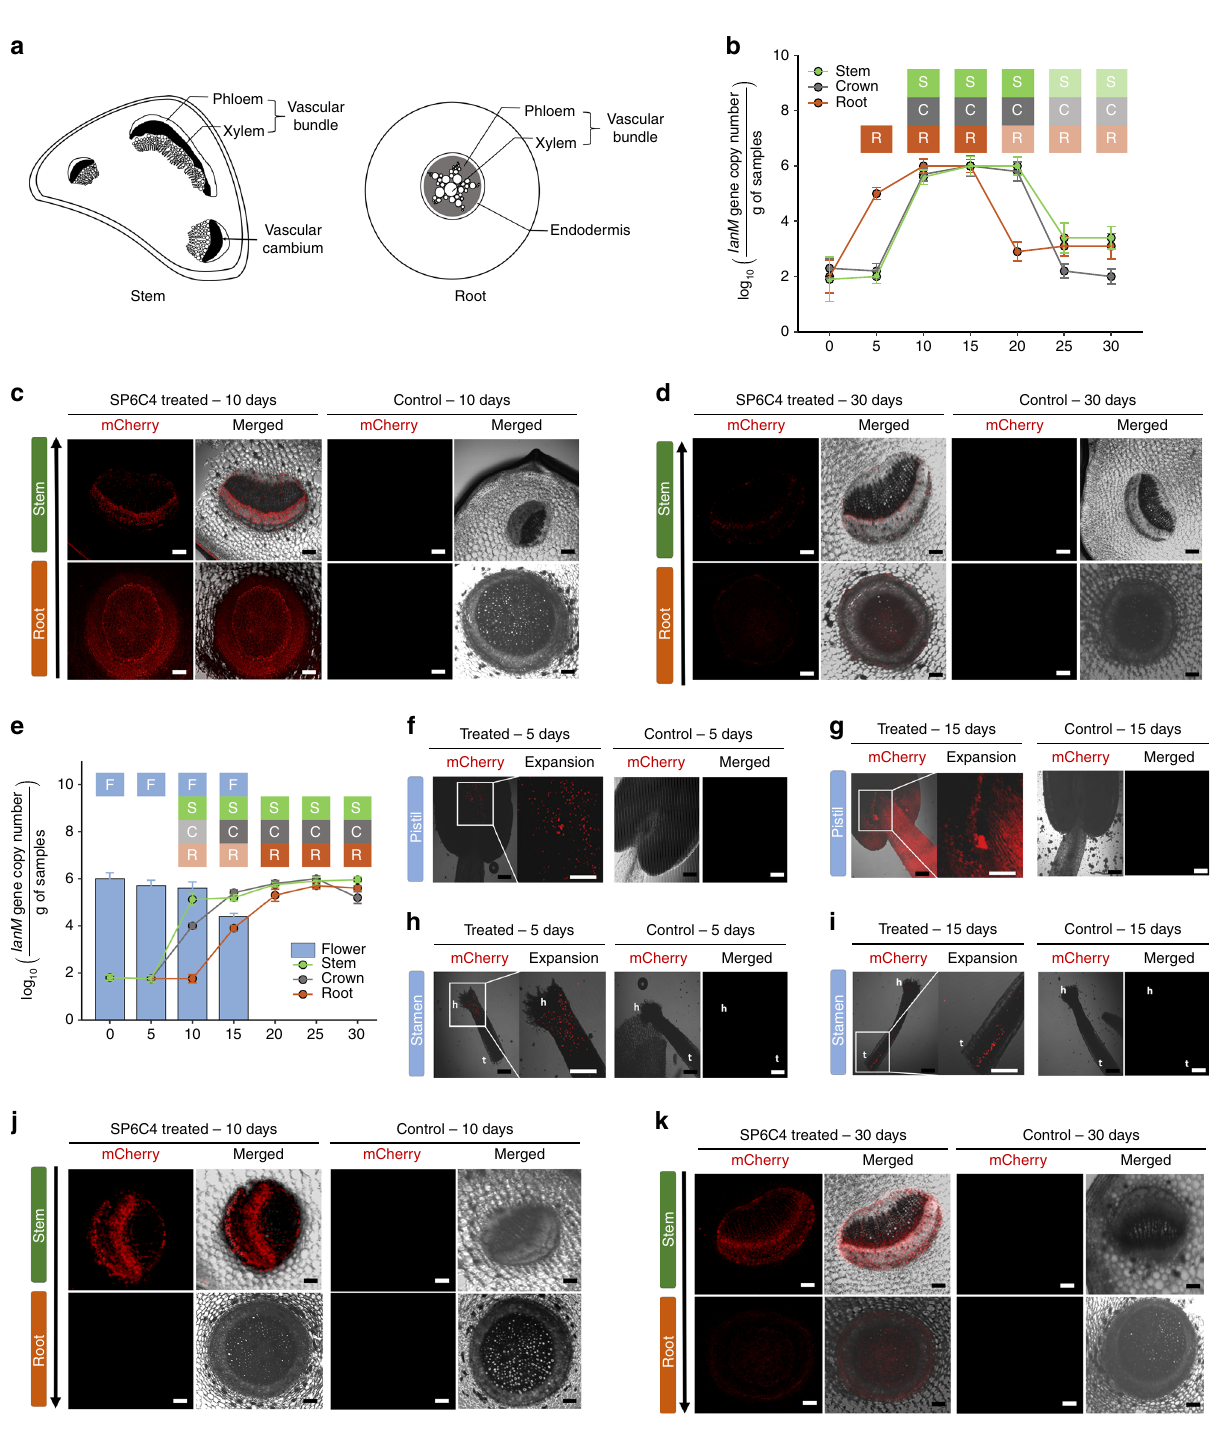
Fig. 4 Translocation of the S. globisporus SP6C4 from below- to above-ground and vice versa. a Illustration of the cross section of a strawberry stem and root. b S. globisporus SP6C4 was introduced onto the root surface in a suspension with 0.1% methyl cellulose. S. globisporus SP6C4 was detected with a lanM -speci fi c primer using qPCR SYBR Green ® TOYOBO master mix. Bars represent ± SE ( n = 3, 3 independent experiments). c Confocal microscopy of plant samples sectioned at 10 days. d 30 days after inoculation. Fluorescence of strain SP6C4-mCherry (530 – 560 nm detection channels) showing translocation from the rhizosphere to above-ground tissue. e Strain SP6C4 introduced on the fl ower and detected by lanM -speci fi c qPCR. Movement of the strain from above- to below-ground plant parts. Bars represent ± SE ( fl ower: n = 5, 3 independent experiments; root and stem: n = 3, 3 independent experiments; crown: n = 3, 3 independent experiments). f SP6C4-mCherry on the pistil at 5 days (mCherry channel scale bar, 100 μ m), 15 days samples ( g ). h SP6C4-mCherry on stamen at 5 days ( i ) and 15 days stem and root at 15 days ( j ). k 30 days after inoculation. The plant was maintained in a growth chamber with 16 h light, 28 °C, 45% relative humidity, and 8 h dark, 24 °C, 45% relative humidity. b , e Source data are provided as a Source Data fi